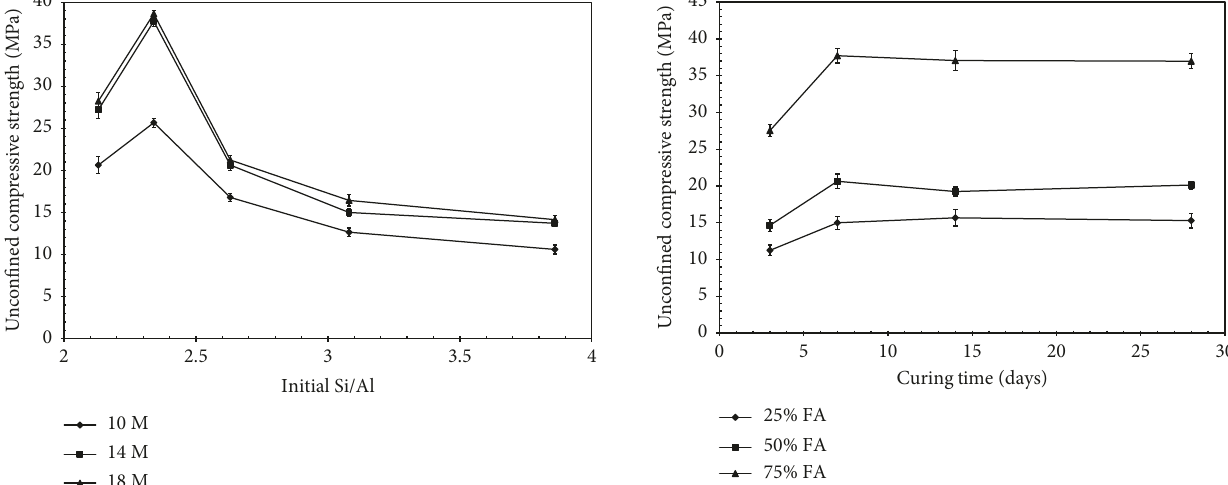
Figure 5: UCS versus curing time with different FA content at M NaOH